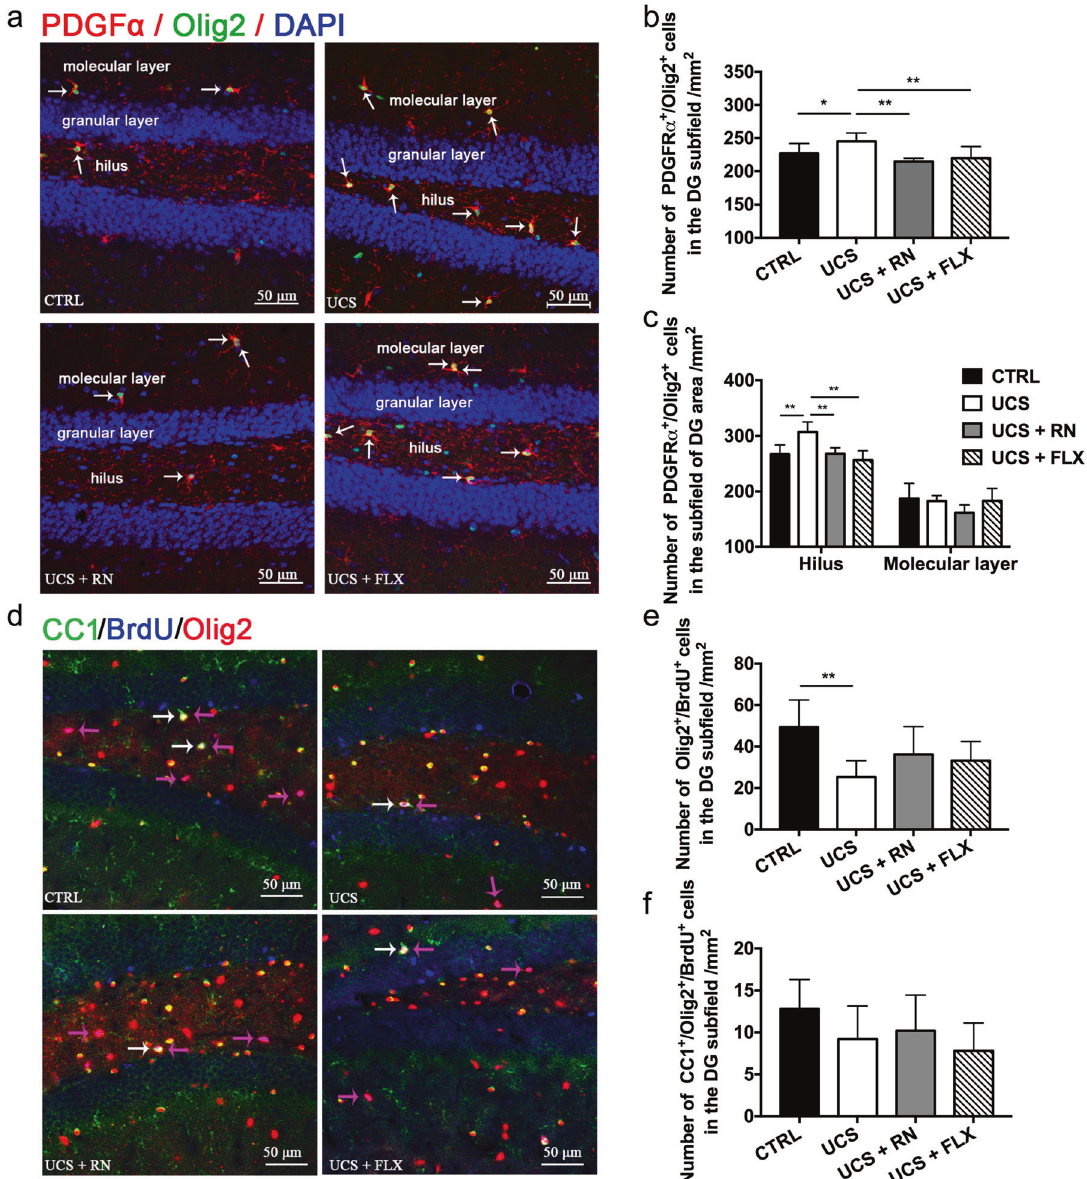
Fig. 5 The effects of running exercise and fl uoxetine on the OPC proliferation and differentiation in the DG sub fi eld of the hippocampus. a Colocalization of PDGF α + and Olig2 + cells in the DG hippocampal sub fi eld. PDGF α + : red, Olig2 + : green, DAPI: blue. The white arrows indicate the PDGF α + /Olig2 + /DAPI co-labeled cells. Scale bar = 50 μ m. b The number of PDGF α + /Olig2 + OPCs in the DG sub fi eld of mice in the CTRL group, UCS group, UCS + RN group, and UCS + FLX group ( n = 5 for each group). c Immuno fl uorescence analyses of the PDGF α + /Olig2 + cells in the hilus and molecular layer of mice in the CTRL group, UCS group, UCS + RN group, and UCS + FLX group ( n = 5 for each group). d Colocalization of the CC1 + , Olig2 + , and BrdU + cells in the DG sub fi eld of the hippocampus. CC1 + : red, Olig2 + : green, BrdU + : blue. The white arrows indicate the CC1 + /Olig2 + /BrdU + co-labeled cells, and the pink arrows indicate the Olig2 + /BrdU + co-labeled cells. Scale bar = 50 μ m. e – f Immuno fl uorescence analyses of the BrdU + /Olig2 + and CC1 + /BrdU + /Olig2 + cells in the DG sub fi eld of mice in the CTRL group, UCS group, UCS + RN group, and UCS + FLX group ( n = 5 for each group). All data are shown as the means ± SDs. * P < 0.05 and ** P <